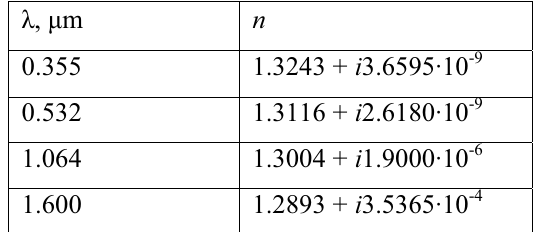
Table 1 Refractive indices (n) for chosen